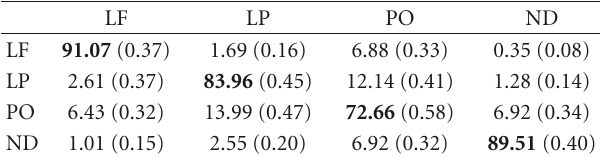
Table 1: Average percentage confusion matrix for testing vectors built from a combination of fluctuation analyses. The possible classes are lack of fusion (LF), lack of penetration (LP), porosity (PO), and no defects (ND). Figures in parenthesis indicate the standard deviations, calculated over 500 sets. (Notice that in [13] these figures were erroneously reported.) The value in row i , column j indicates the percentage of vectors belonging to class i which were associated with class j